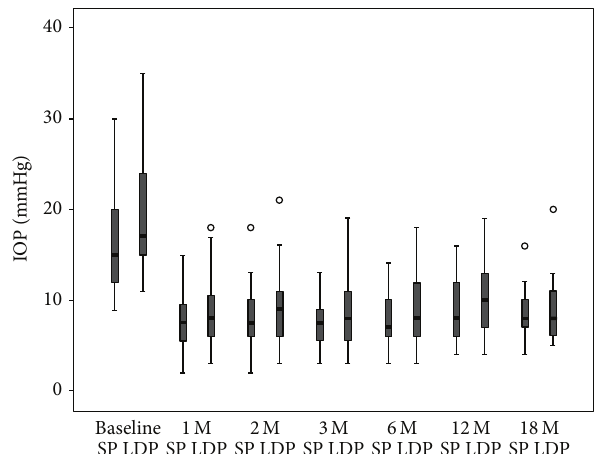
Figure 2: Posture-induced intraocular pressure (IOP) changes measured with an ICare rebound tonometer before and after trabe- culectomyoveran18-monthperiod.TheIOPsinboththesittingand the lateral decubitus positions were decreased at every visit after the trabeculectomy ( 𝑃 < 0.01 every visit; Bonferroni test). The IOP in the lateral decubitus position was significantly increased ( 𝑃 < 0.05 ; paired 𝑡 -test). The squares, upper bars, and lower bars indicate 25– 75%, 95%, and 5% percentiles,